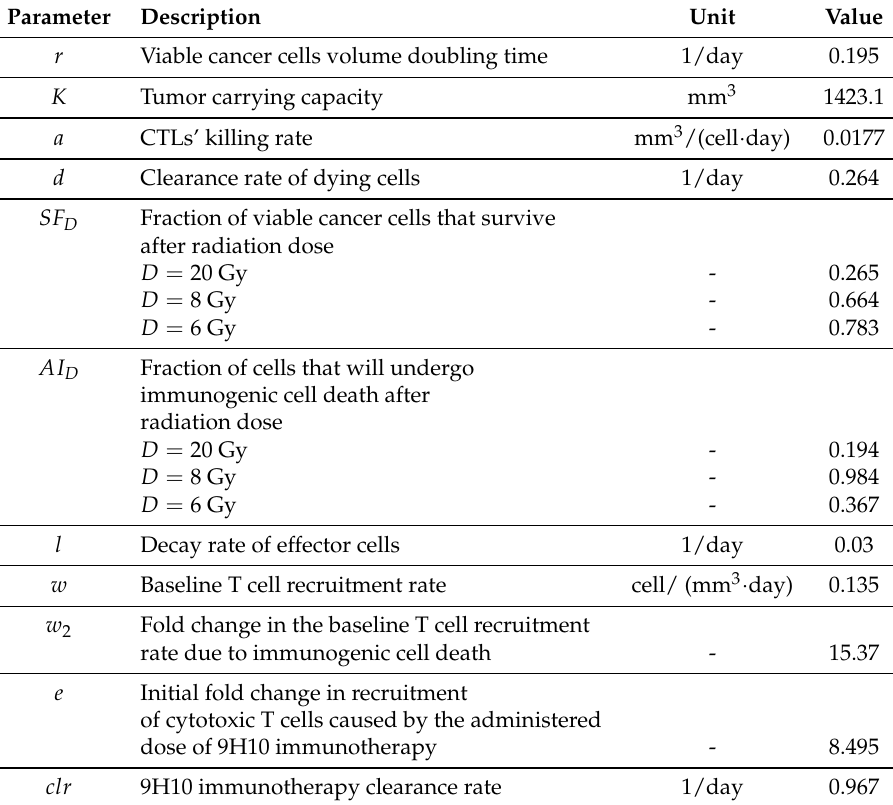
Table 1. Model (Equations (3)–(10)) parameters and derived